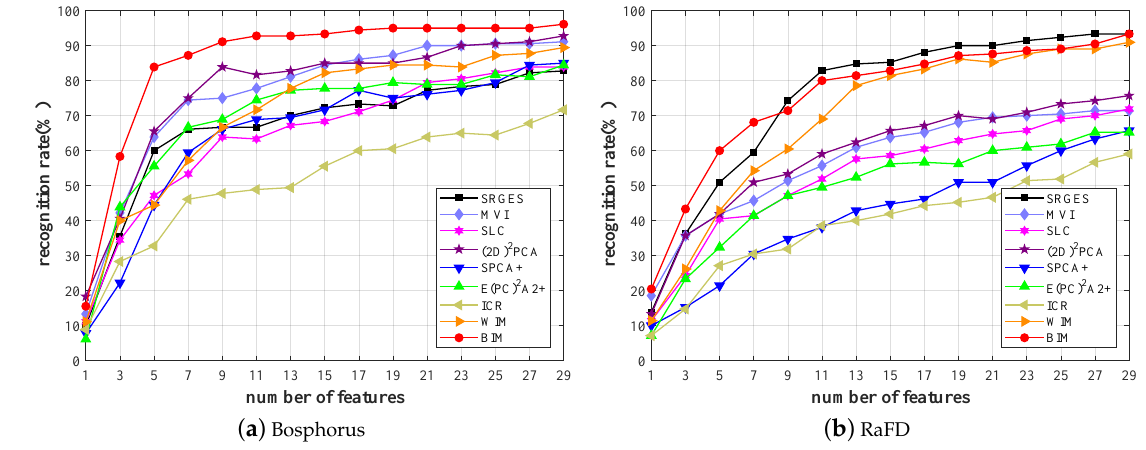
Figure 6. Face recognition results for a various number of DCV features in “ Closed Set ”